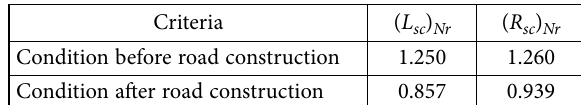
lower and upper bound value as ( ) the left and right scores for an attribute for both rating and weight be and for the weight as